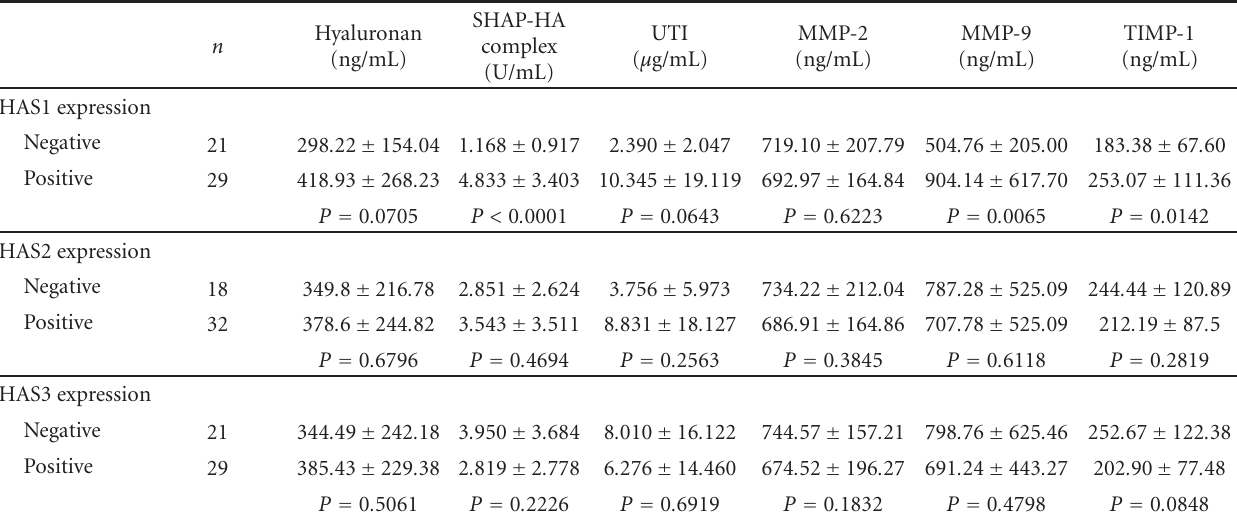
Table 4: Serum HA, SHAP-HA complex, MMP-2, MMP-9, TIMP-1, and UTI in relation to the expression of HAS1, HAS2, and HAS3 in patients with endometrial